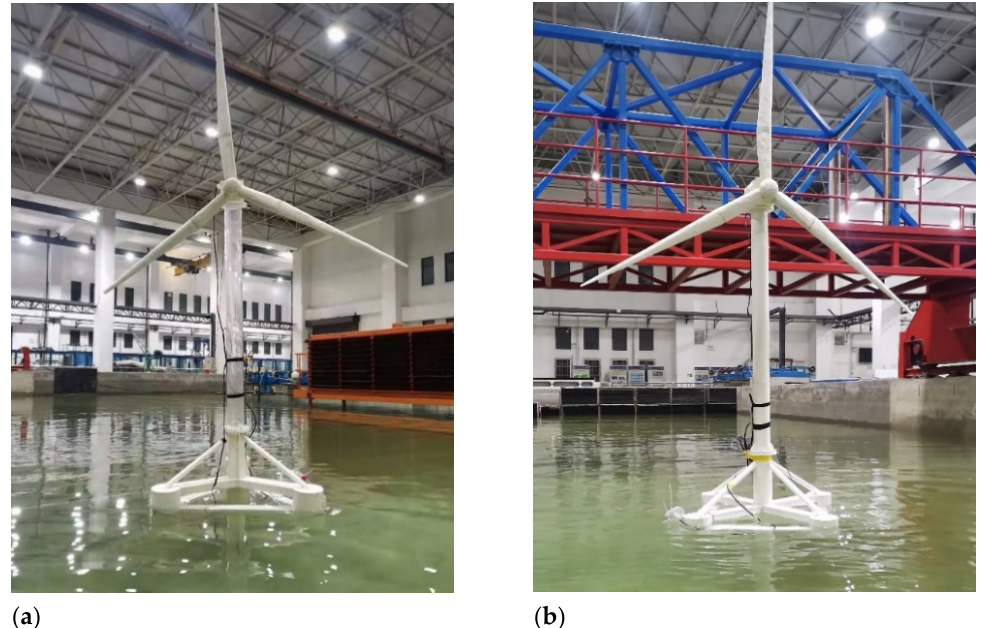
Figure 7. Model-scale of 10MW TC-SFOWT and FC-SFOWT in the wave basin. ( a ) TC-SFOWT, ( b ) FC-SFOWFT. Table 3. Load case for verification of numerical model. Table 4. Comparison results for model validation in full scale. (Note: Num., Exp., and Max. are the abbreviations for numerical, experimental, and maximum).